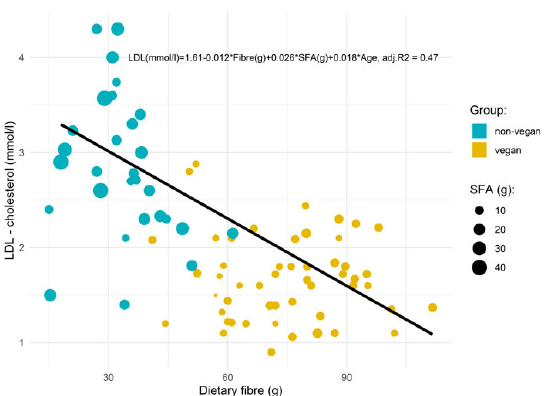
Figure 2. Multivariate regression relationship between fiber, SFA intake and age and LDL choles ‐ terol.